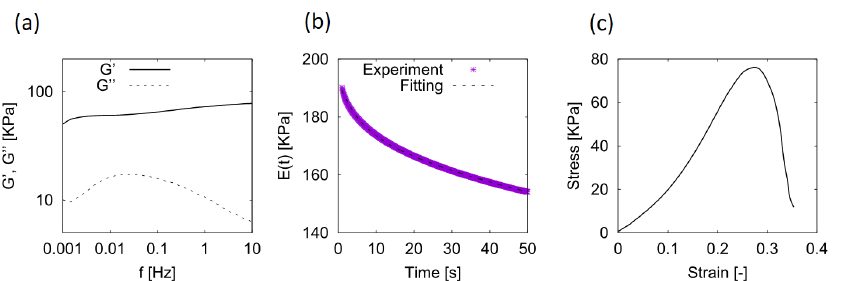
Figure 9. ( a ) Linear viscoelastic moduli G (cid:48) ( f ) (storage modulus) and G ” ( f ) (loss modulus) at room temperature, ( b ) typical example of stress-relaxation behavior ( l = 25 mm, w = 10 mm, h = 5 mm), and ( c ) stress–strain curve for the uni-axial compression